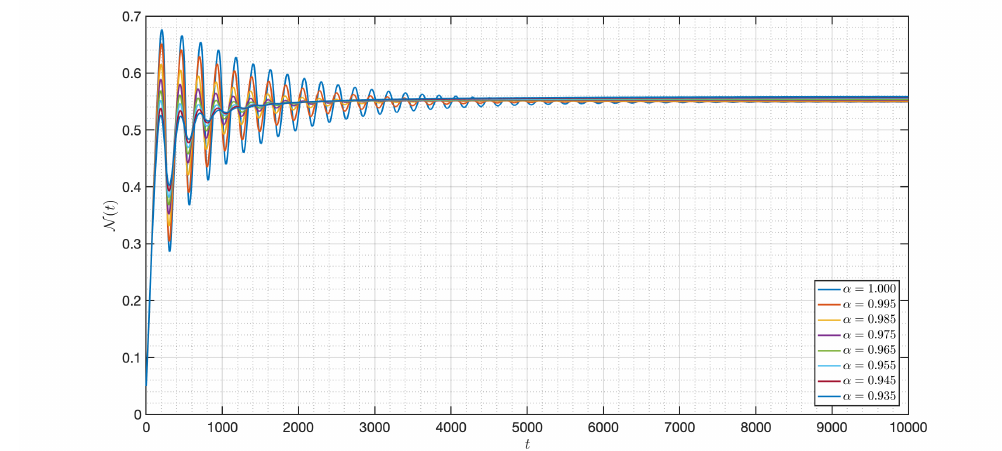
Figure 1. Dynamic of the model (3) for different parameters in Case I with α = 1.000.